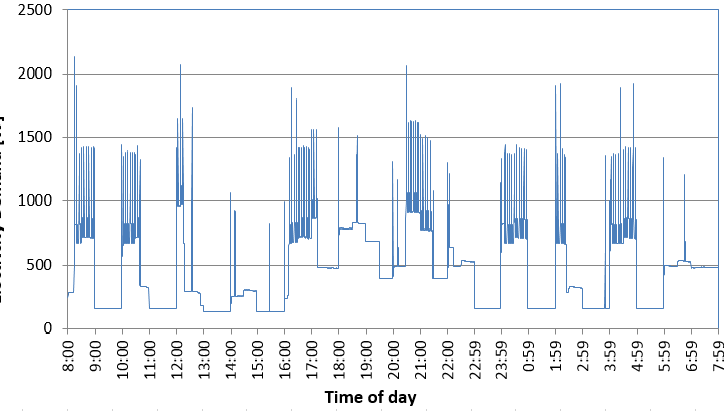
Figure 8. Simulated house load profile (24 h).